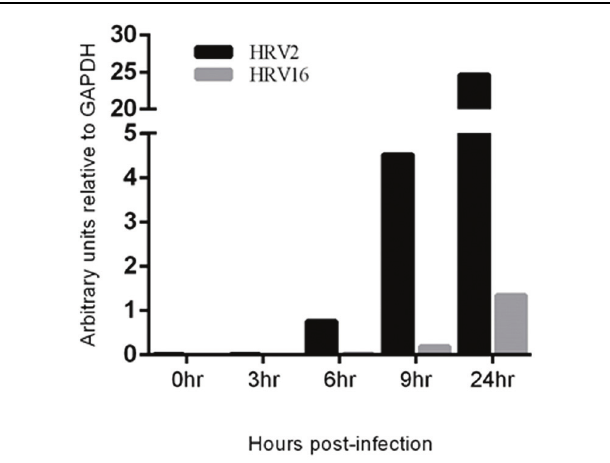
FIGURE 5 | Viral RNA replication is detectable earlier in HRV2 infection compared to HRV16 infection. Real-time PCR was used to assess the quantity of viral RNA present in infected cells at the specified time points for HRV2 and HRV16 infection. Data is shown as arbitrary units relative to